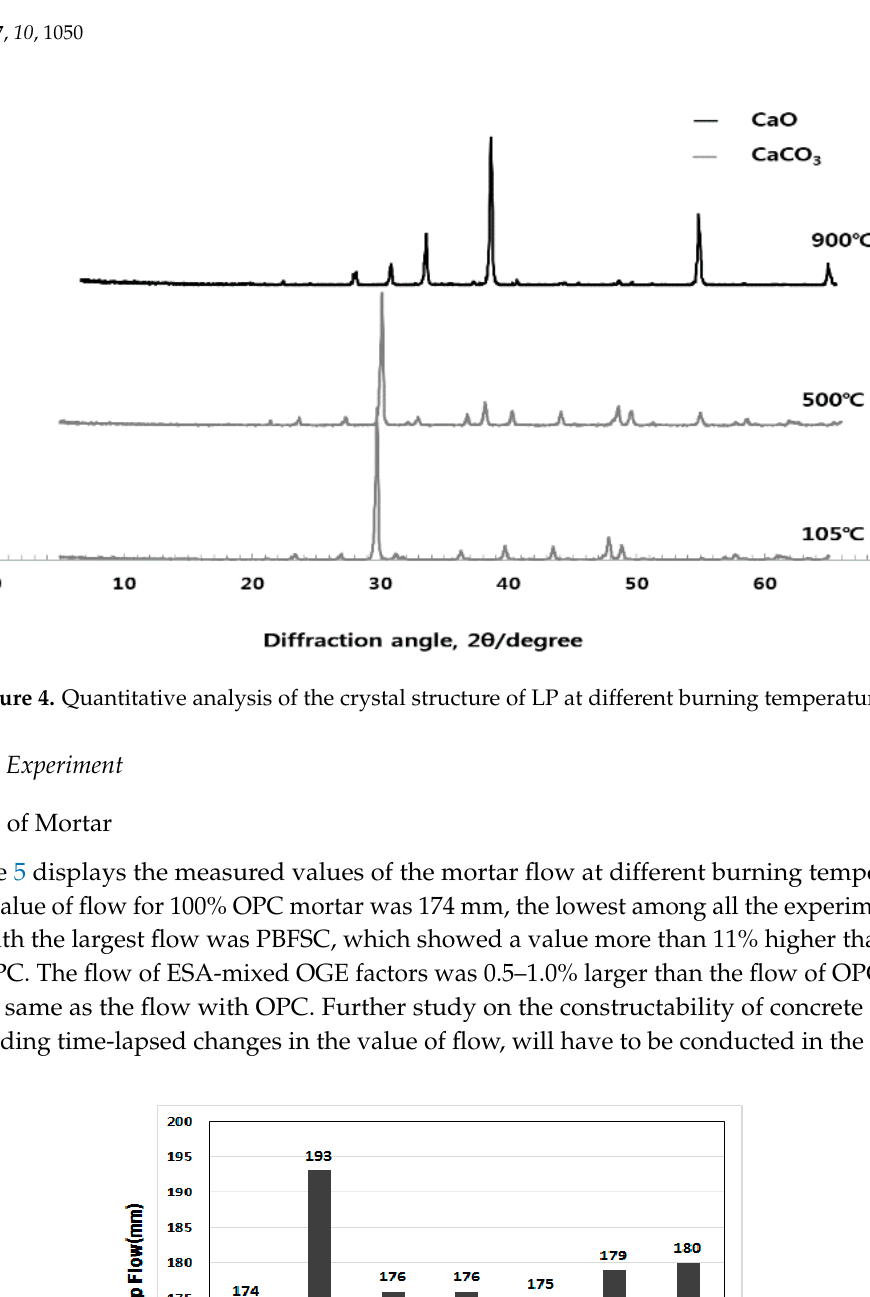
Figure 3. Quantitative analysis of the crystal structure of sludge at different burning temperatures.